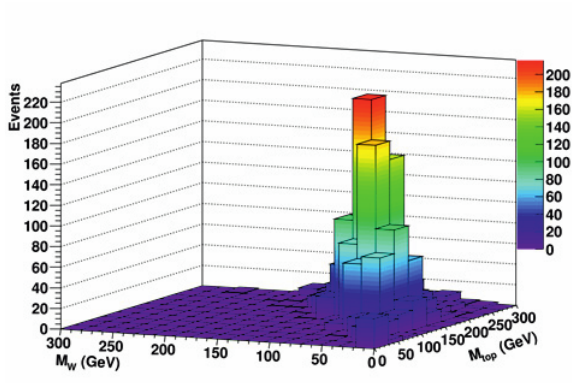
Figure 4. Reconstructed m t and m W per event for a sample of signal and background events corresponding to an intergrated luminosity of 1 fb − 1